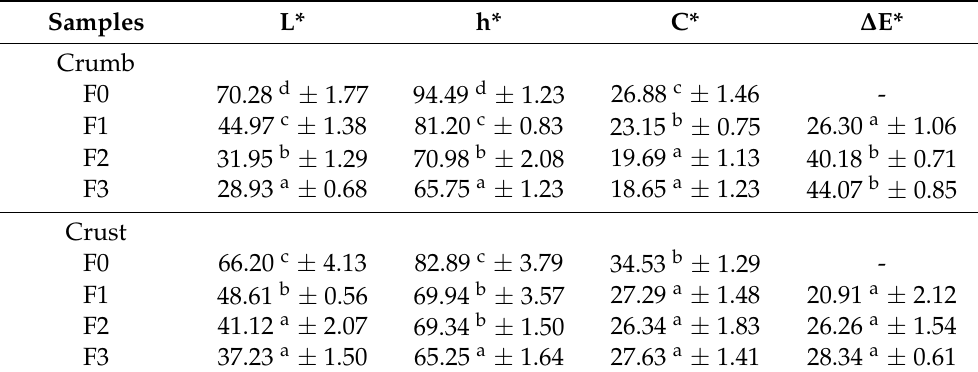
Table 2. Crumb and crust color attributes (L*, h*, and C*) and total color differences ( ∆ E*) of the